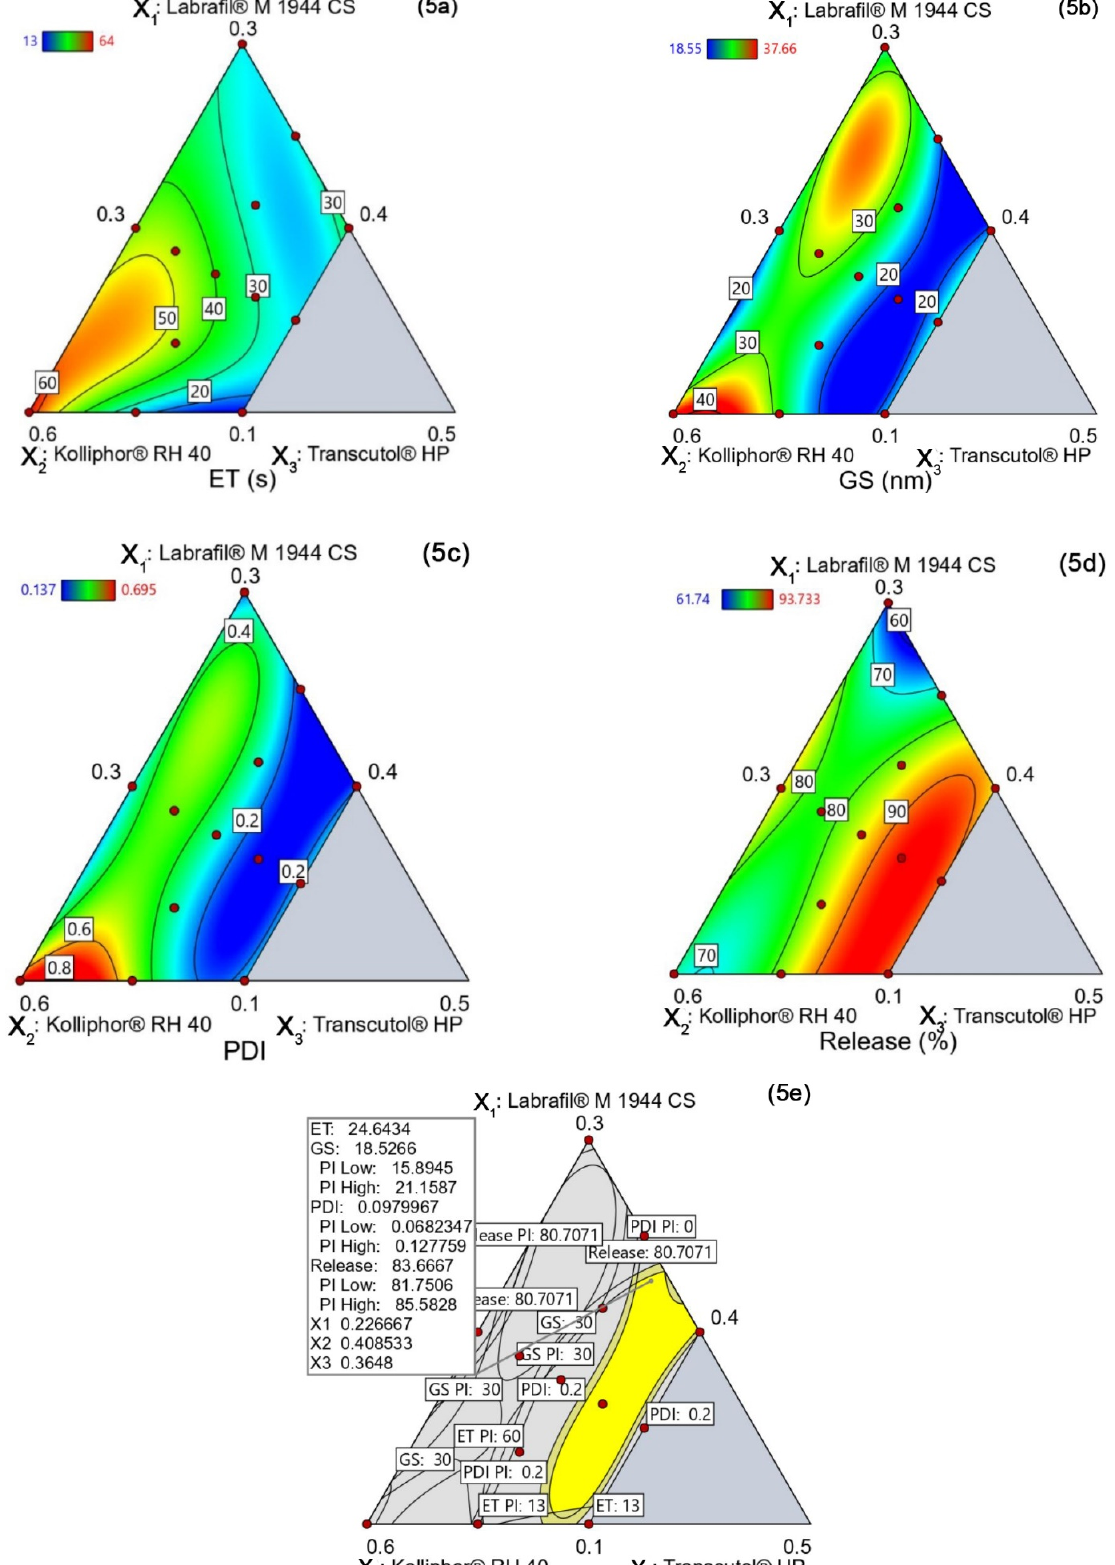
Figure 5. The contour plots of the four CQA responses ( a ) ET, ( b ) GS, ( c ) PDI, ( d ) Release, and ( e ) overlay plots represent the design space.